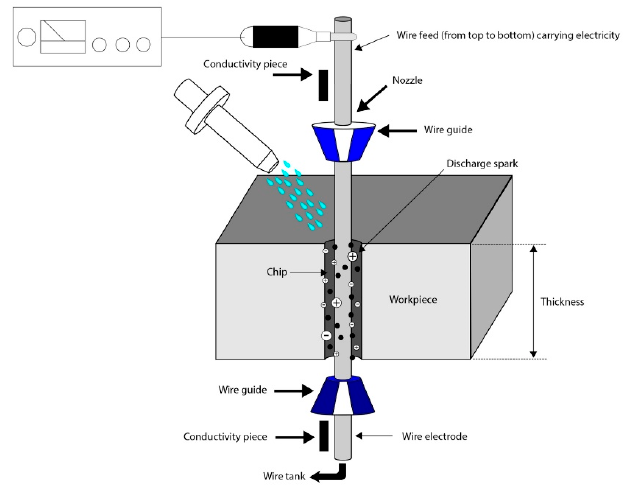
Figure 6 . Measurement of Amplitude in Vibration - Assisted EDM Process .